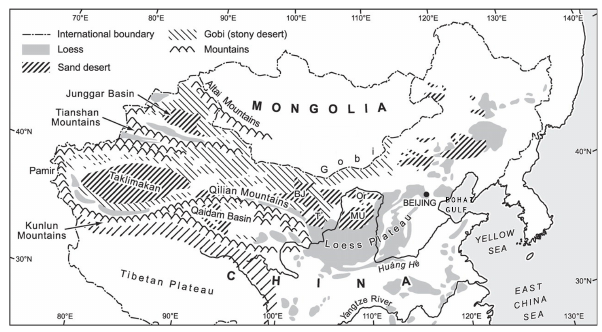
Fig. 1. The distribution map of Chinese Loess Plateau and sur- rounding primary desert dust source areas (Maher et al.,